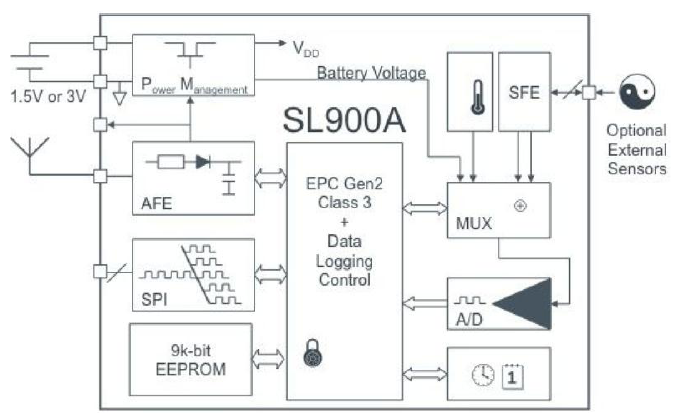
Figure 3. Temperature sensor chip structure diagram.